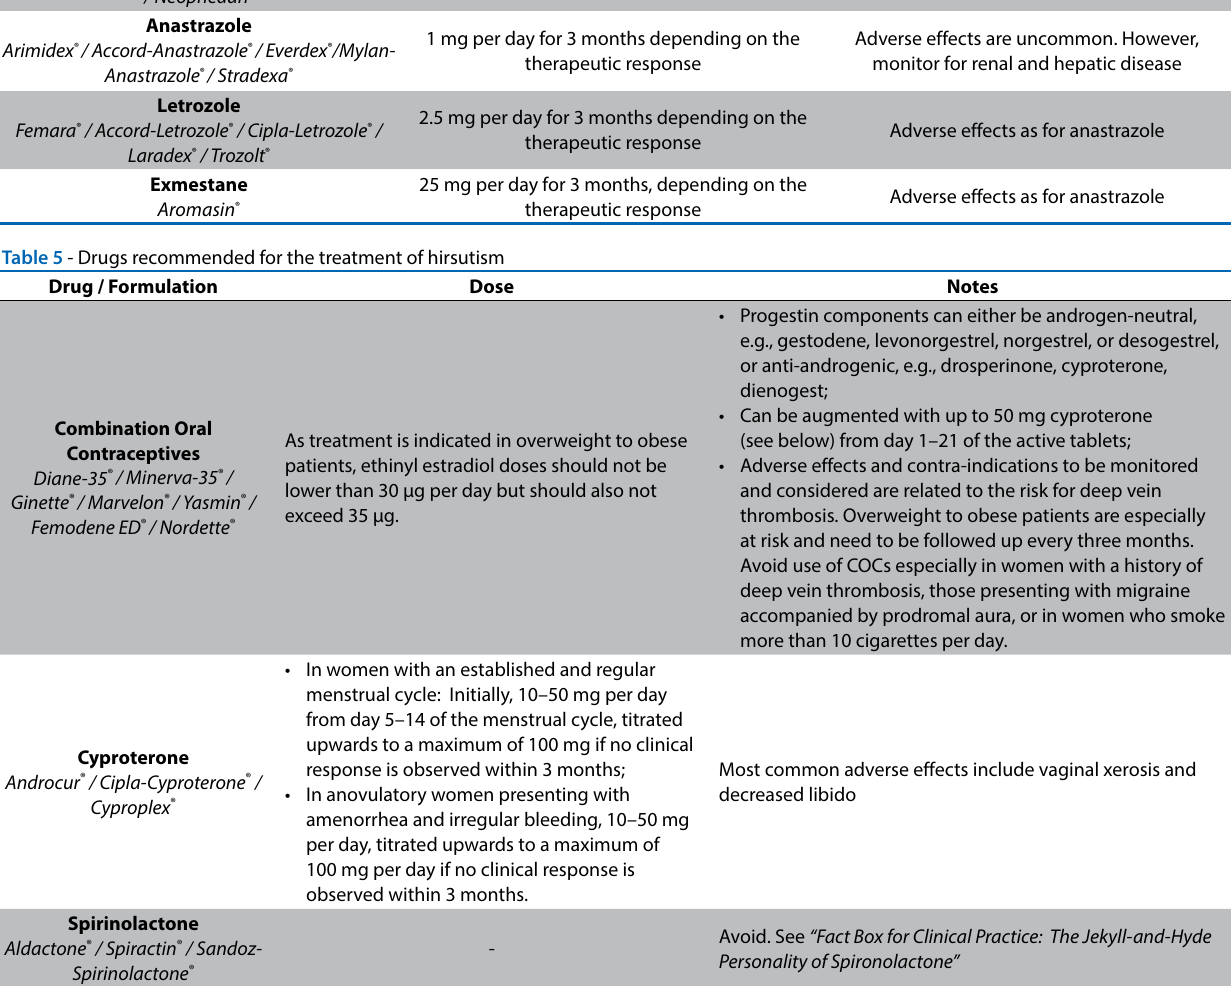
Comorbid conditions in women Hirsutism